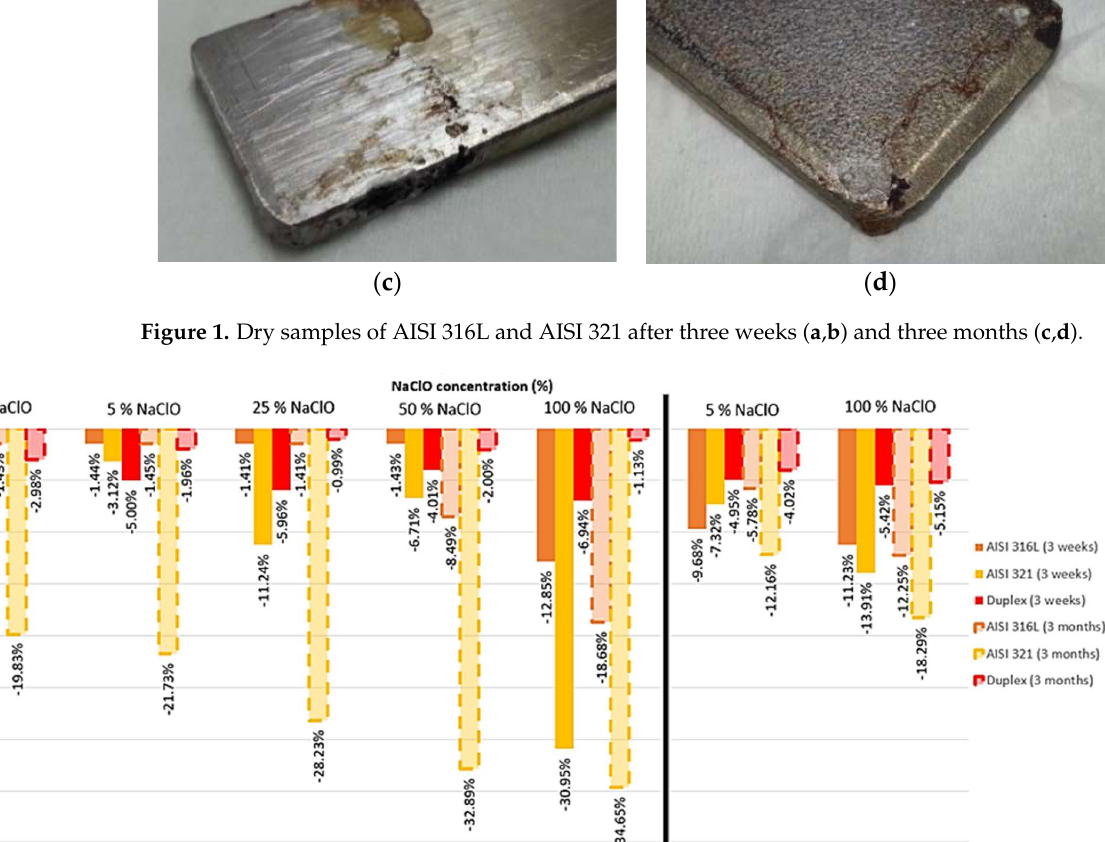
Figure 2. Mass variation of all the samples after three weeks and three months of immersion.